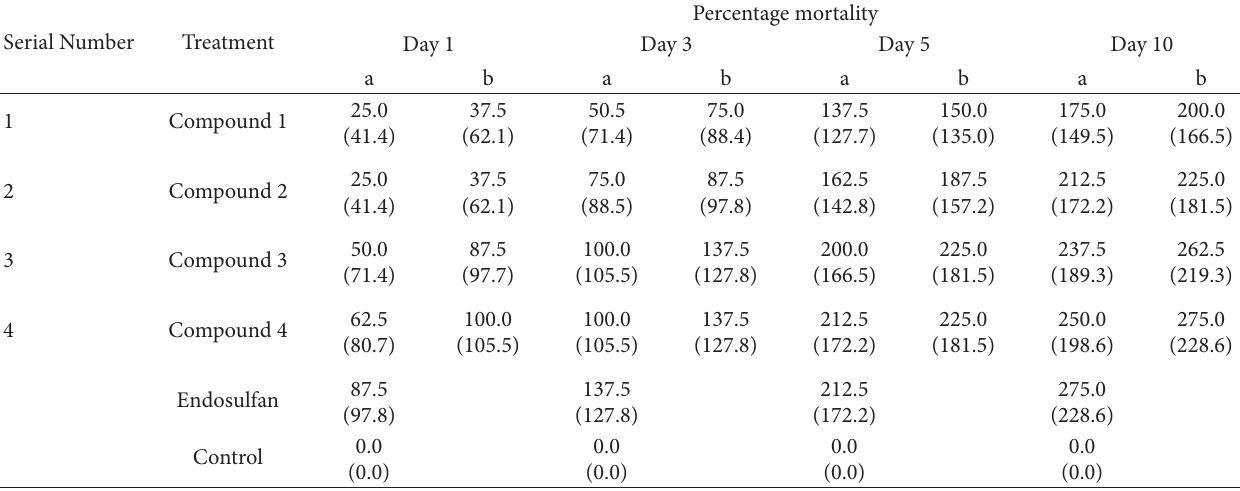
T 5: Percentage mortality of Helicoverpa armigera pest aer 1, 3, 7, and 10 days. Total percent mortality